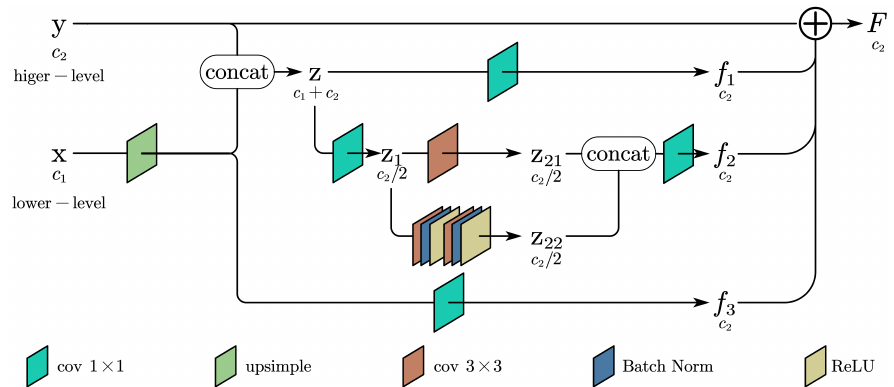
Figure 2. Structure of half-level fusion